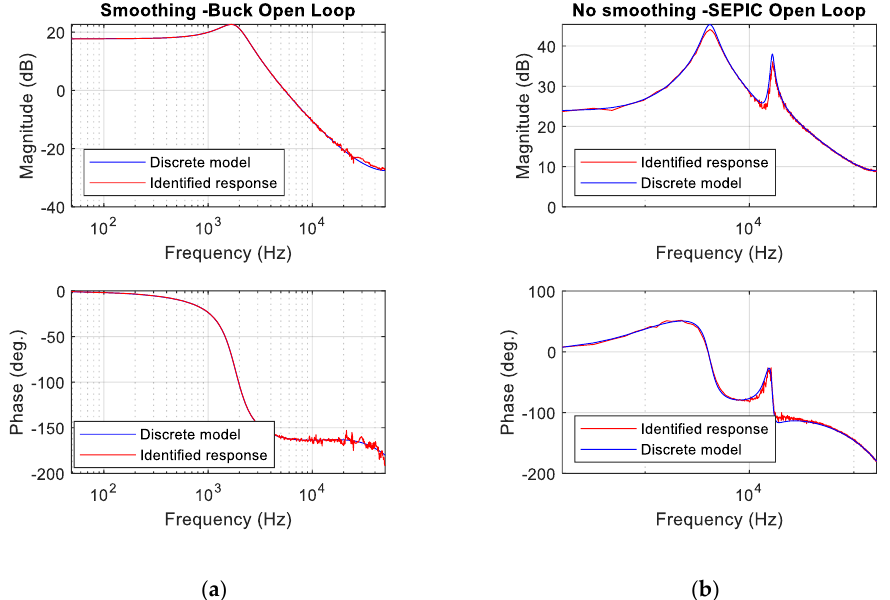
Figure 8. Simulation of the proposed identification procedure. ( a ) Control to output voltage transfer function for the buck converter in Figure 7a. ( b ) Control to inductor current transfer function for the SEPIC converter in Figure 7b.